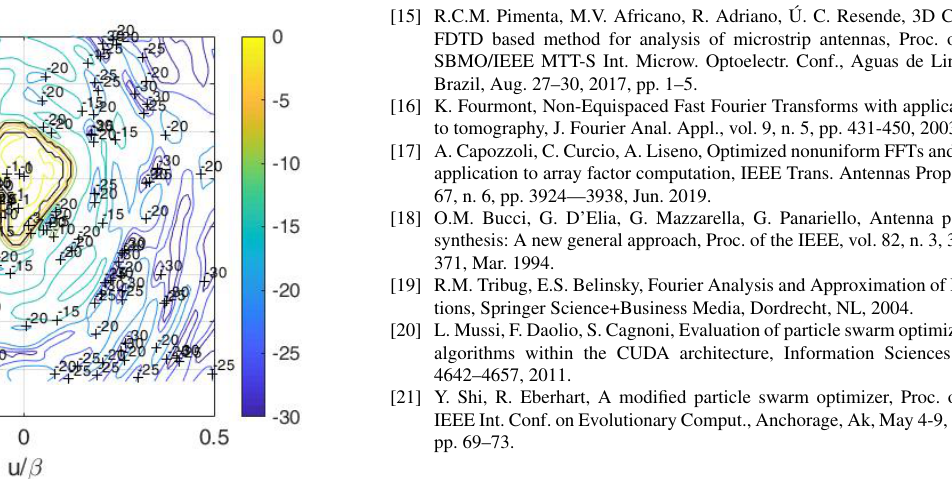
FIGURE 7. Directivity pattern synthesized by a local optimizer using an impulse-based phase representation and skipping PSO.